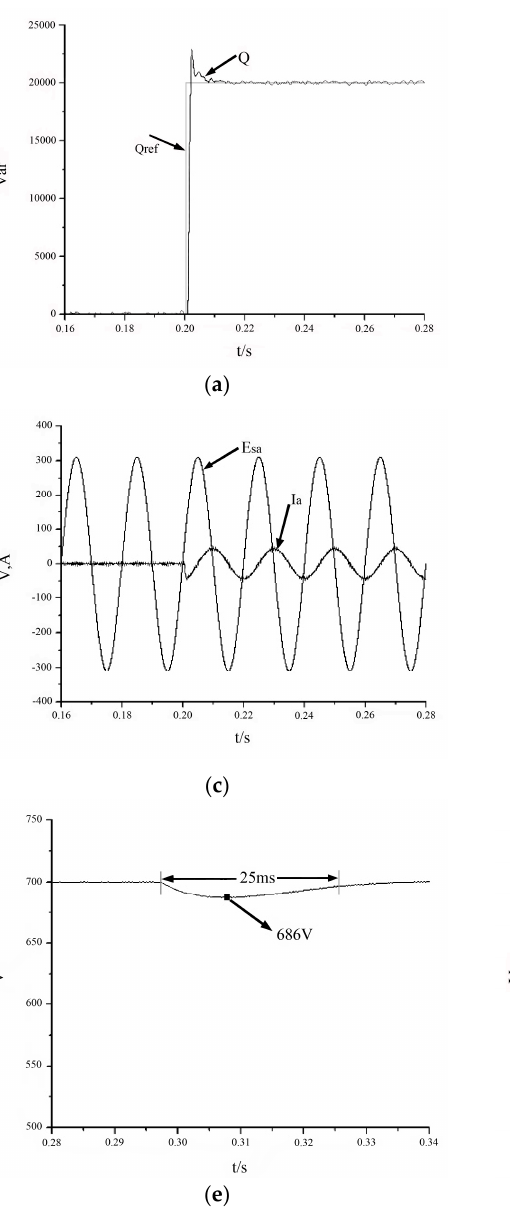
Figure 12. ( a ) Jump of the reactive power; ( b ) voltage of DC side; ( c ) voltage and current of AC side; ( d ) current spectrum; ( e ) voltage of DC side with external disturbances; ( f ) voltage of DC side with internal disturbances.